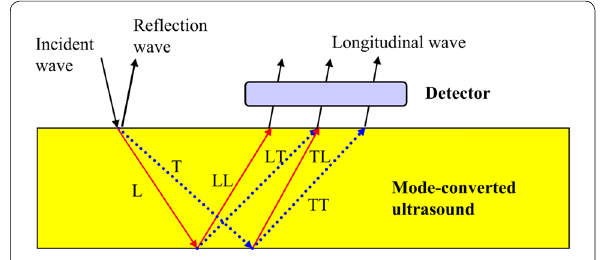
Figure 10 Ultrasonic mode conversion in a bounded solid [6]